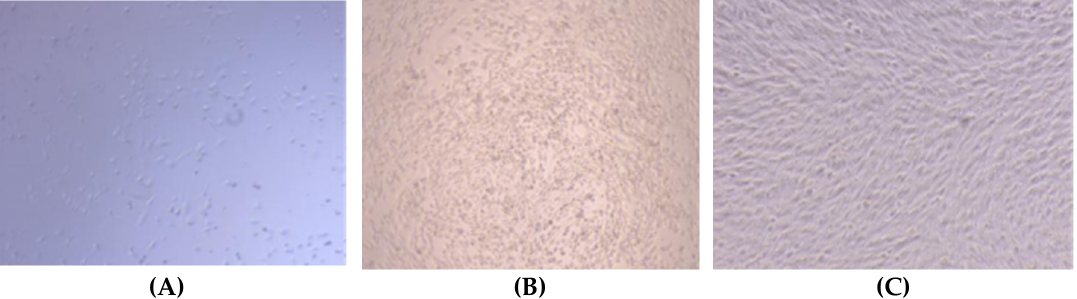
Figure 8. Cell morphology of MC3T3-E1 in SCSC at different days of culture. ( A ) Culture for 1 day; ( B ) culture for 3 days; ( C ) culture for 5 days.